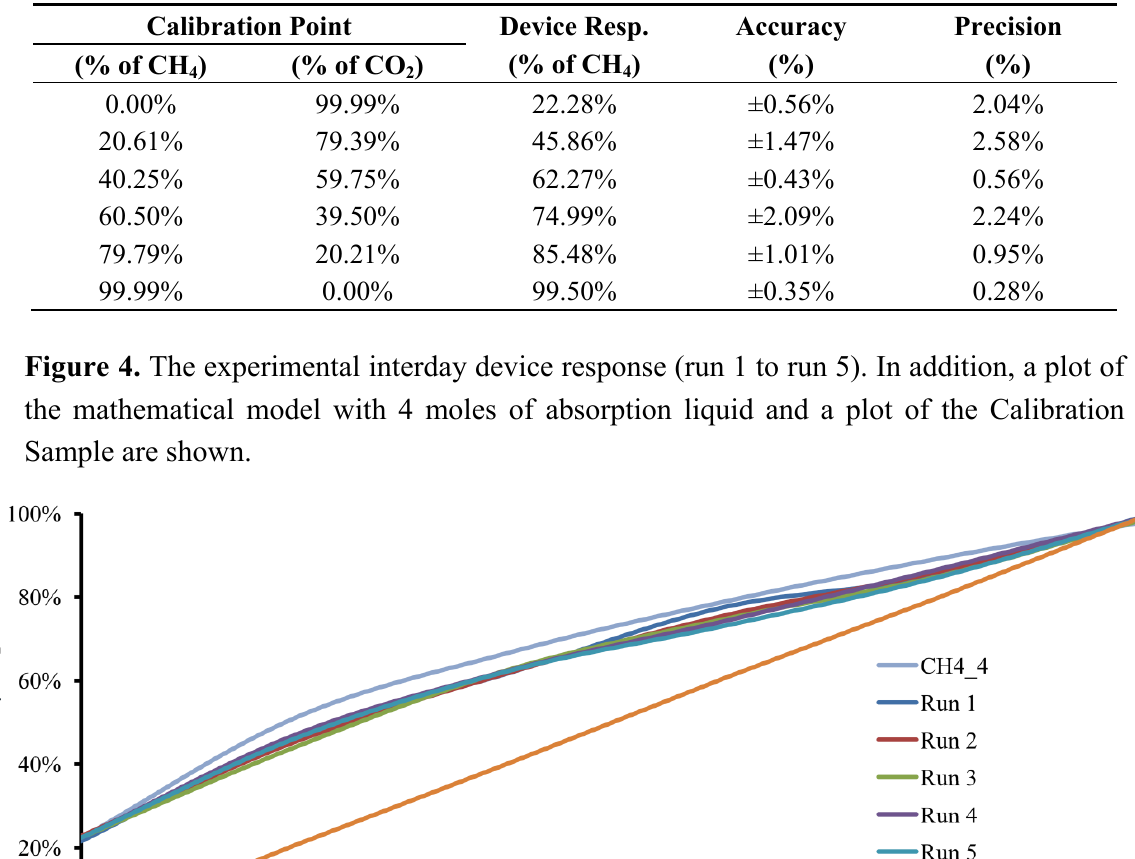
Table 1. Statistical characteristics obtained from the experimental data.